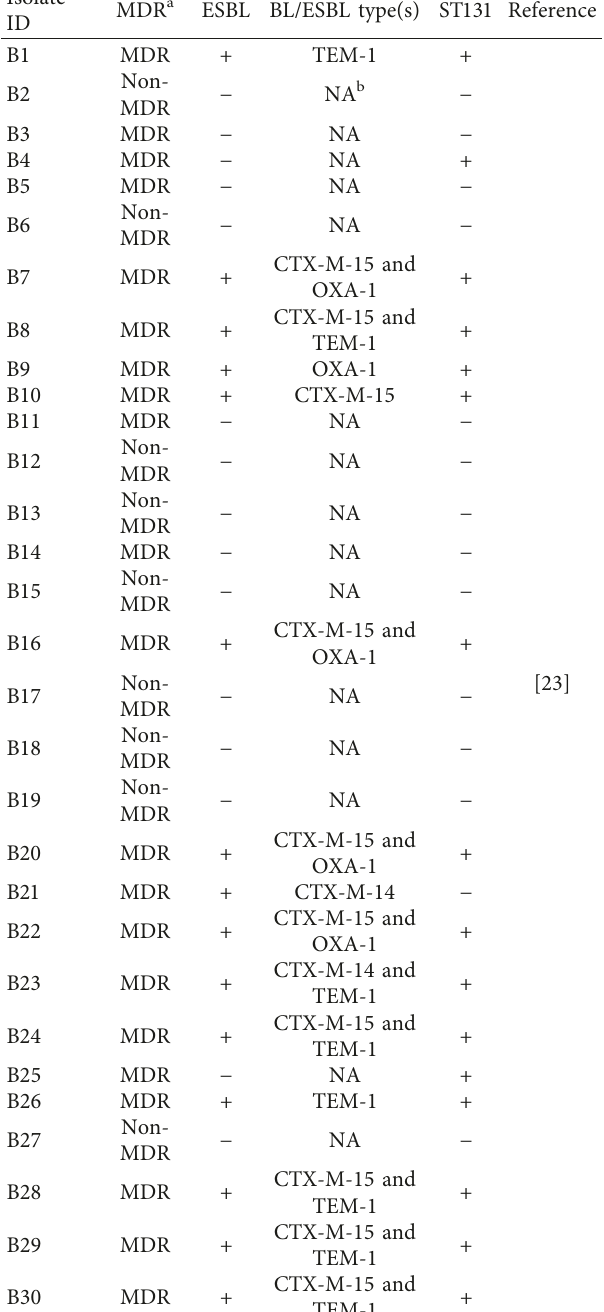
Table 1: Information on the E. coli blood isolates used in this study. Isolate